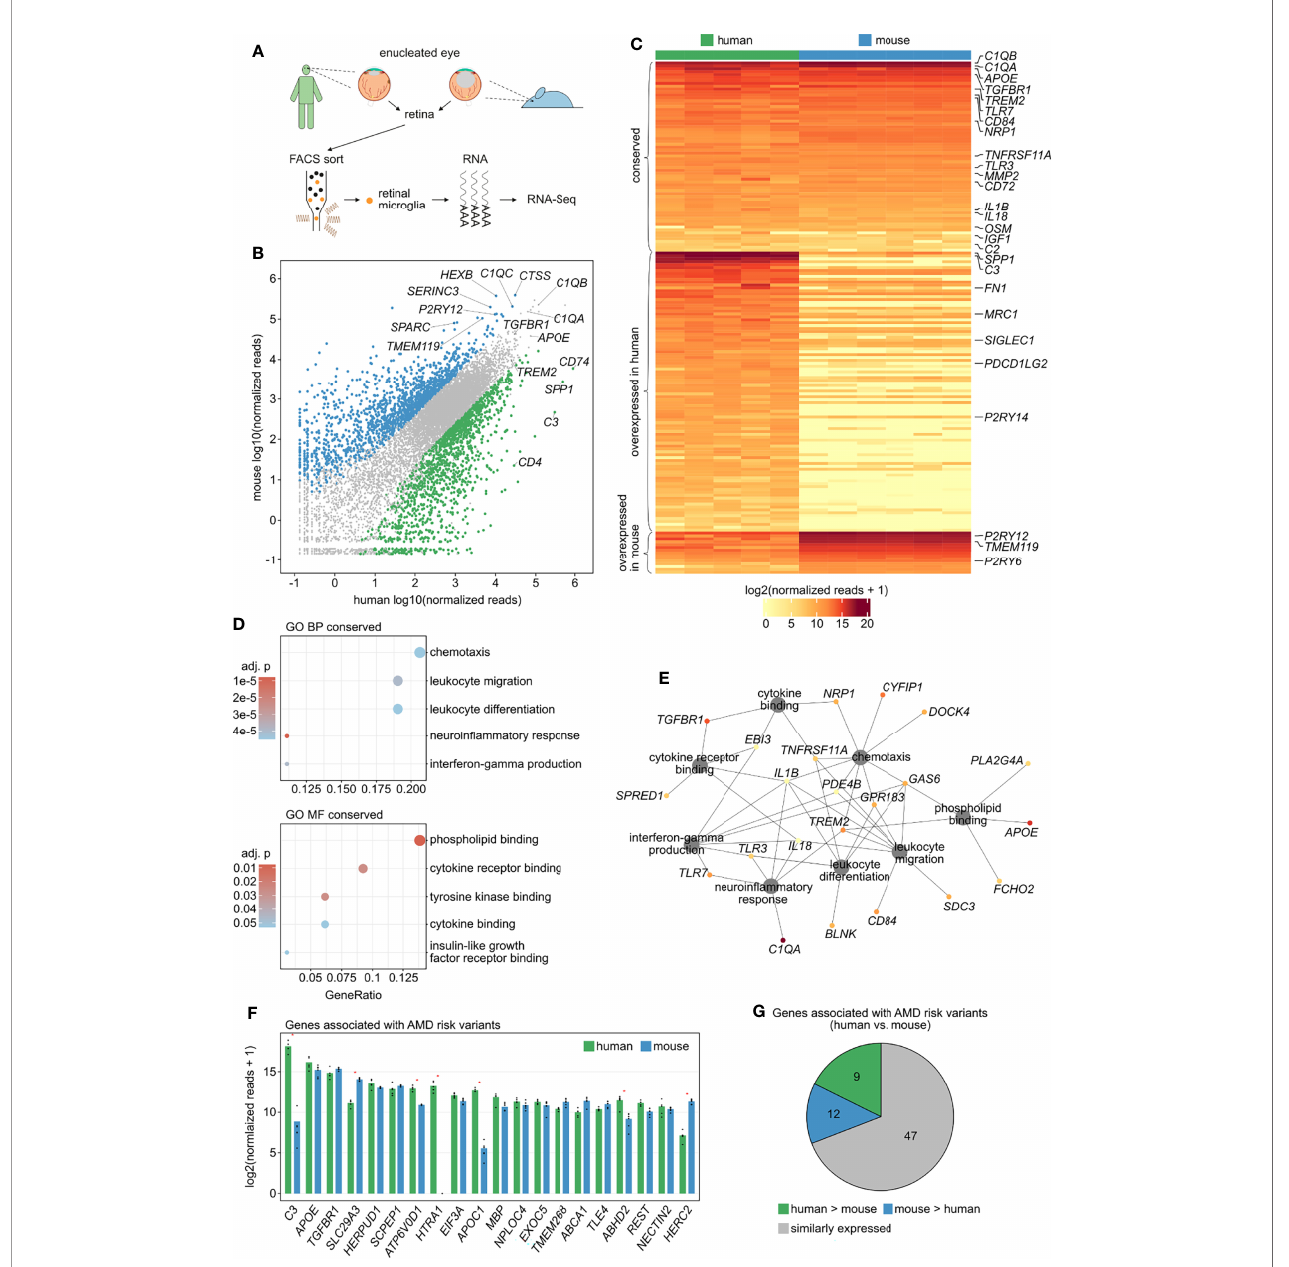
FIGURE 3 | Comparison of human and murine retinal microglia transcriptional pro fi les. (A) Experimental setup: retinal microglia were FACS-isolated from fi ve human enucleated eyes (CD45 + CD11b + CX 3 CR1 + MatMac + CCR2 - ) as well as from enucleated eyes from six Cx3cr1 GFP/+ mice (CD45 low CD11b + CX 3 CR1 + Ly6C - Ly6G - ) followed by RNA sequencing. (B) Read plot visualizing expression levels of 11822 one-to-one orthologous genes in human and mouse retinal microglia highlighting differentially expressed genes in human (green) and mouse (blue) (log2FC > 2, adjusted p < 0.05). (C) Heatmap of the expression of retinal microglia-enriched genes identi fi ed in human ( Figure 2C ) compared with mice, with an one-to-one orthologous gene found for 178 of the 249 genes. Transcripts with comparable expression between human and mouse are provided as conserved factors at the top of the heatmap (n = 66). Overexpressed factors in human (n = 97) and mouse (n = 15) are visualized in the center and at the bottom of the heatmap, respectively (log2FC > 2, adjusted p < 0.05). (D) Dotplots visualizing the top fi ve Gene ontology (GO) biological processes (BP) and molecular functions (MF), which the conserved genes in retinal microglia were involved in. The GeneRatio represents the proportion of associated genes to the total number of conserved genes. The adjusted p-value of each GO term is shown by color. (E) Network diagram visualizing the conserved genes associated with the most signi fi cantly enriched GO biological processes and molecular functions. The color represents mean expression of each gene in human and mouse (legend in C). (F) Bar graphs visualizing the expression levels of the 20 highest expressed genes associated with AMD risk variants in human and mouse retinal microglia. Red asterisks indicate differentially expressed genes (log2FC > 2, adjusted p < 0.05). (G) Pie chart illustrating relative expression of genes associated with AMD risk variants in human and mouse retinal